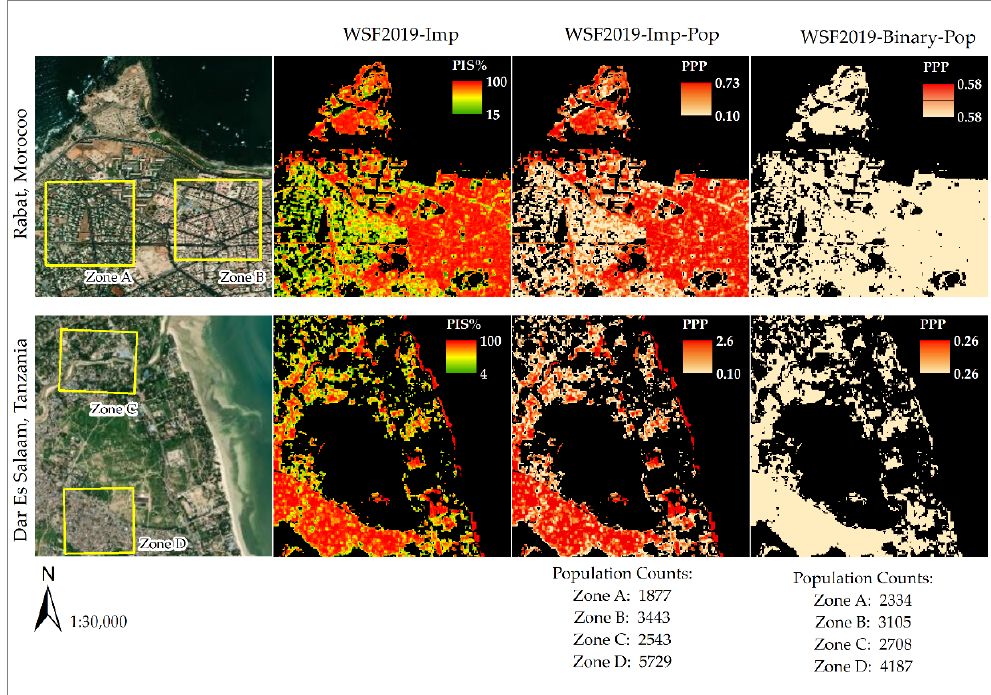
Figure 9. Final population distribution maps produced using the WSF2019-Imp layer and WSF2019 layer for the coastal areas of Rabat, Morocco, and Dar Es Salaam, Tanzania. From each map, population counts were extracted for Zones A, B, C, and D, respectively. Colour ramps depict values in the current extent.